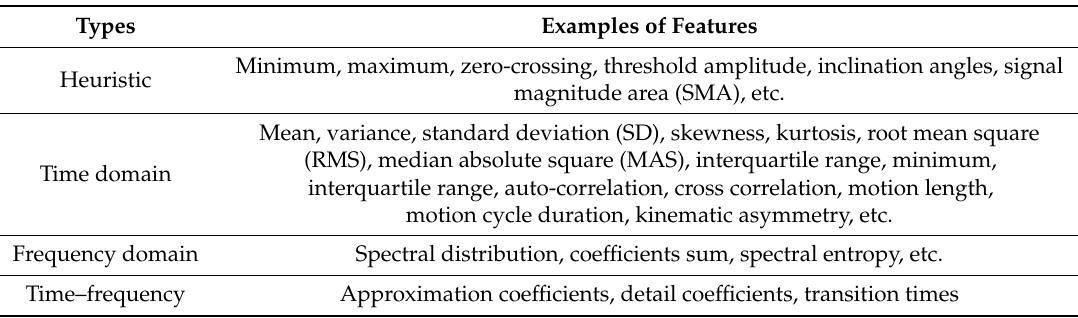
Table 4. Types of features for HAR